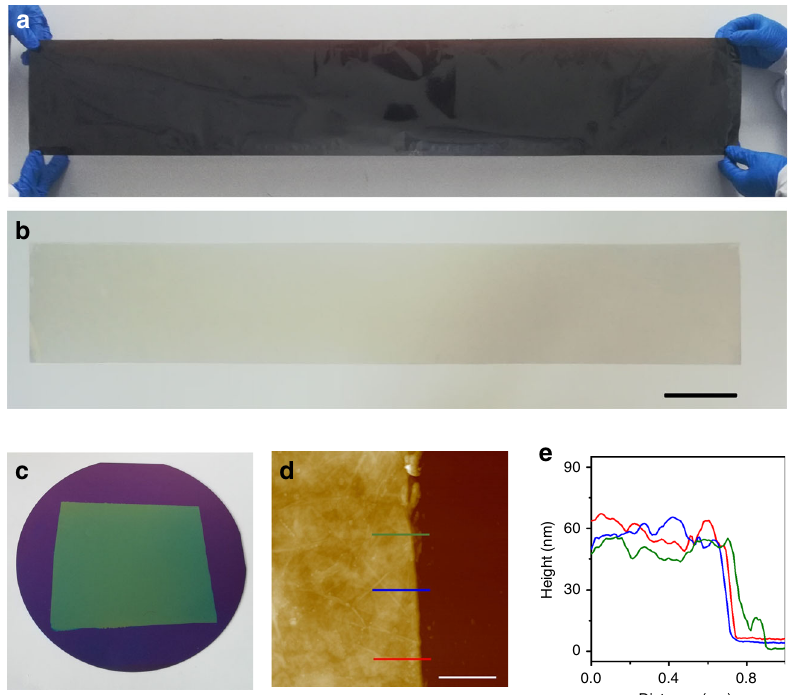
Fig. 2 Scalable production of large-area highly aligned and compact GO fi lms with different thickness. a , b A meter-scale ~10 μ m-thick free-standing GO fi lm ( a ) and thin GO fi lm on polyethylene terephthalate (PET) ( b ) produced with a RHT of 33 cm in inner diameter. c A thin GO fi lm on a 4 inch silicon wafer prepared with the same conditions as those for the production of the fi lm in b . d , e Atomic force microscopy (AFM) image ( d ) of the fi lm in c and the height pro fi les ( e ) along the three lines in d , showing the thickness of ~50 nm. Scale bars: b 10 cm; d 1 μ